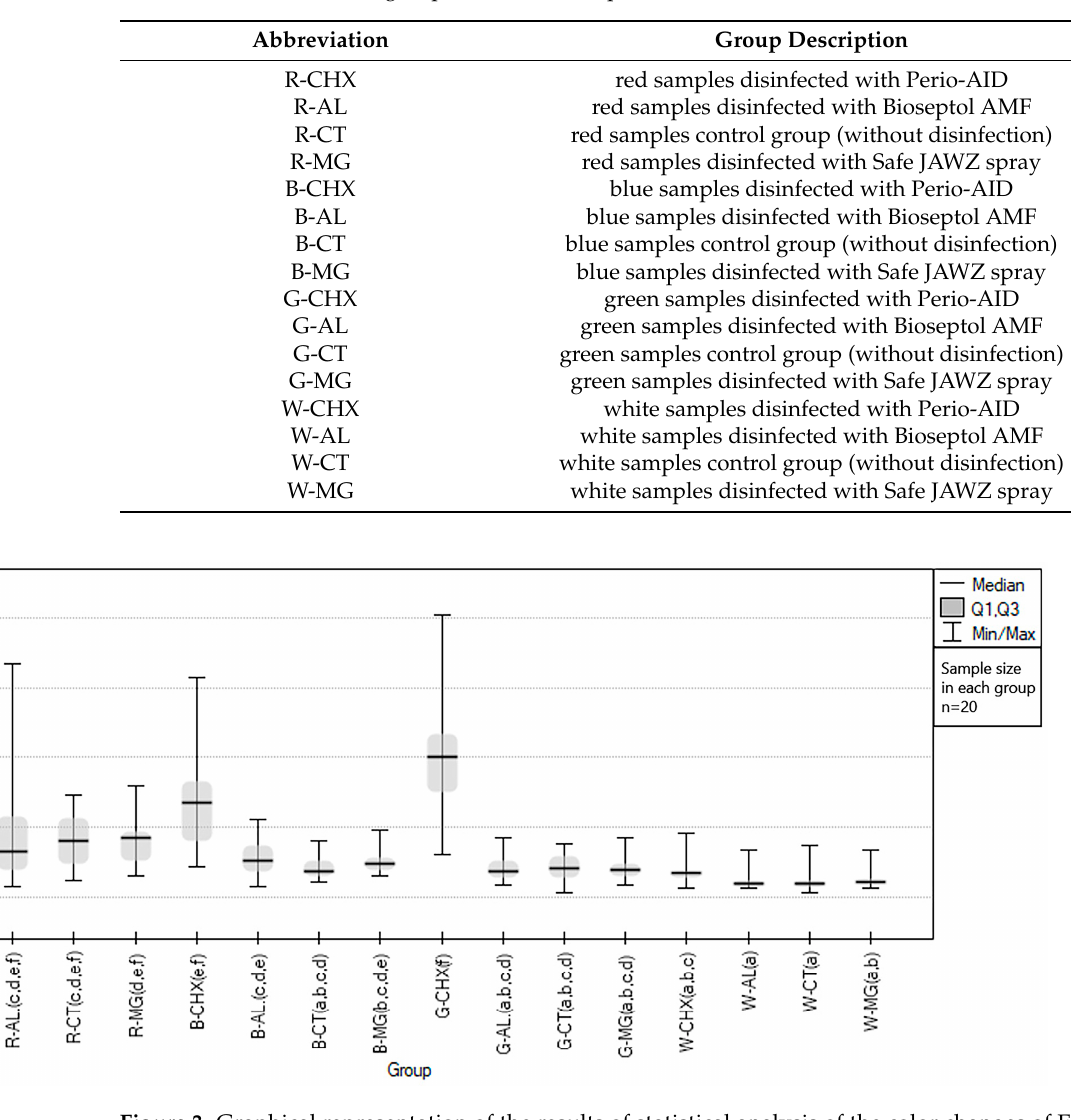
Figure 4. Graphical representation of the results of statistical analysis of the hardness of EVA sam- ples under the influence of disinfecting materials, divided into groups. The same lowercase letters in brackets after the group code indicate homogeneity between the groups in post-hoc Sheffe testing.